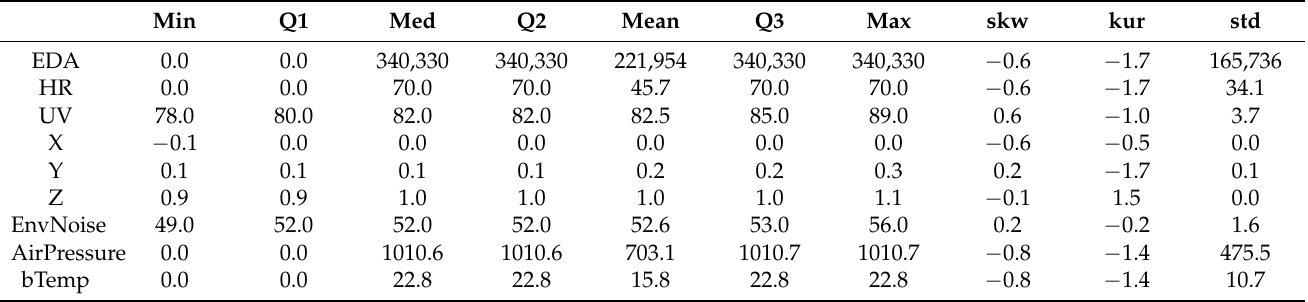
Table 7. Descriptive statistics for the collected